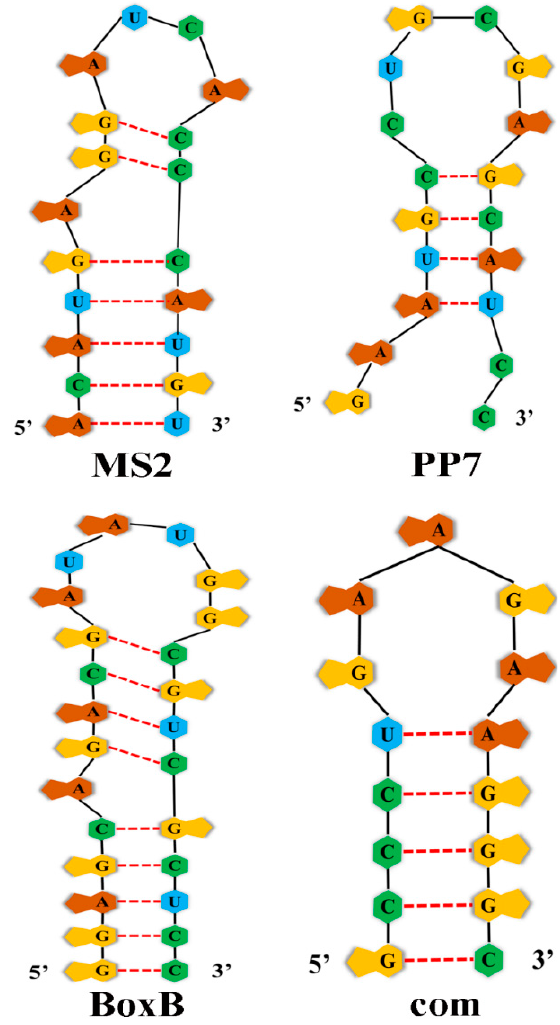
Figure 1. Structure of four RNA aptamers.